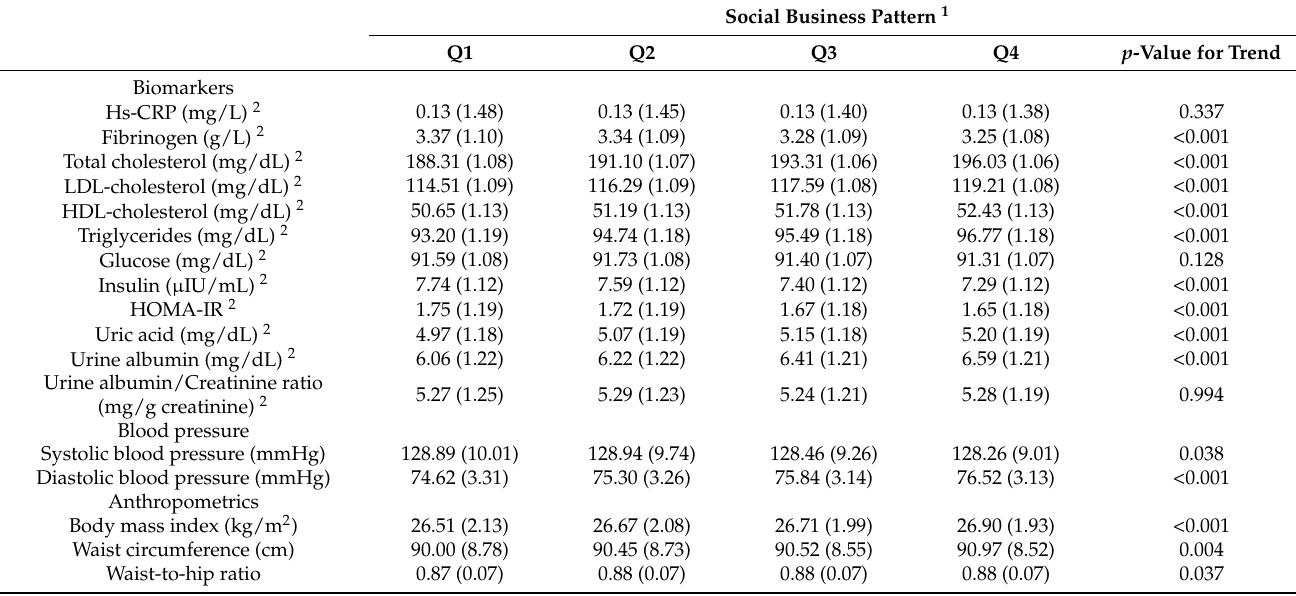
Table 6. Plasma and urine concentrations of inflammatory and cardio-metabolic biomarkers, blood pressure, and anthropo- metrics according to the quartiles of the social business pattern 1